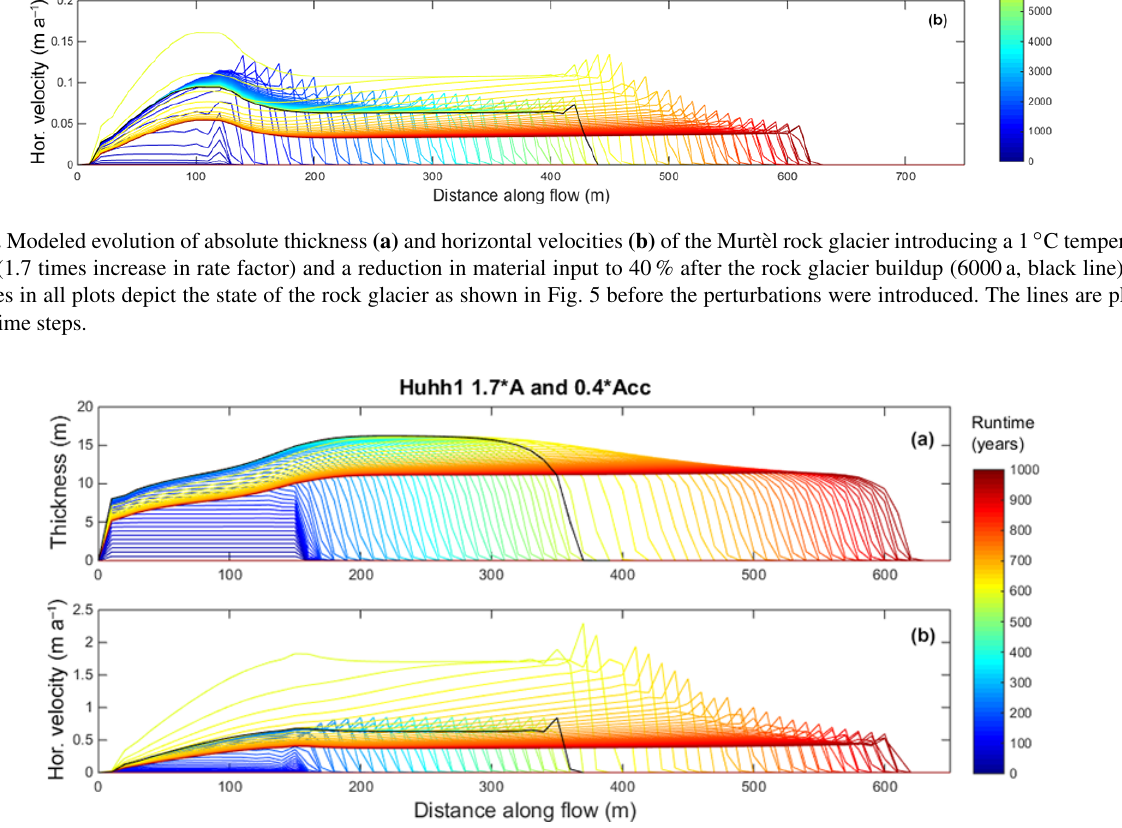
Figure 9. The evolution of absolute thickness (a) and horizontal velocities (b) of the Huhh1 rock glacier introducing a 1 ◦ C temperature increase (1.7 times increase in rate factor) and 40% of the initial material input after rock glacier buildup (600a, black line). The black lines in all plots depict the state of the rock glacier as shown in Fig. 6 before the perturbations were introduced. The lines are plotted in 10a